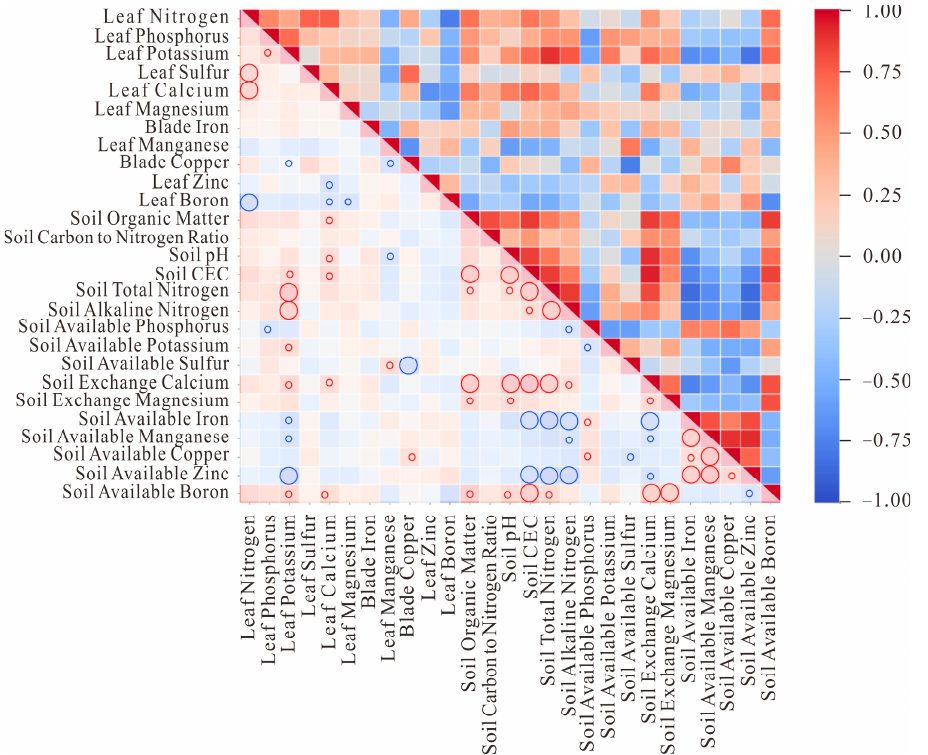
Figure 3. A Spearman correlation between the soil index and leaf nutrient elements in the karst areas. The red and blue circles represent positive and negative correlations, respectively, and the large circles and small circles represent a significance level of 0.01 and 0.05, respectively.